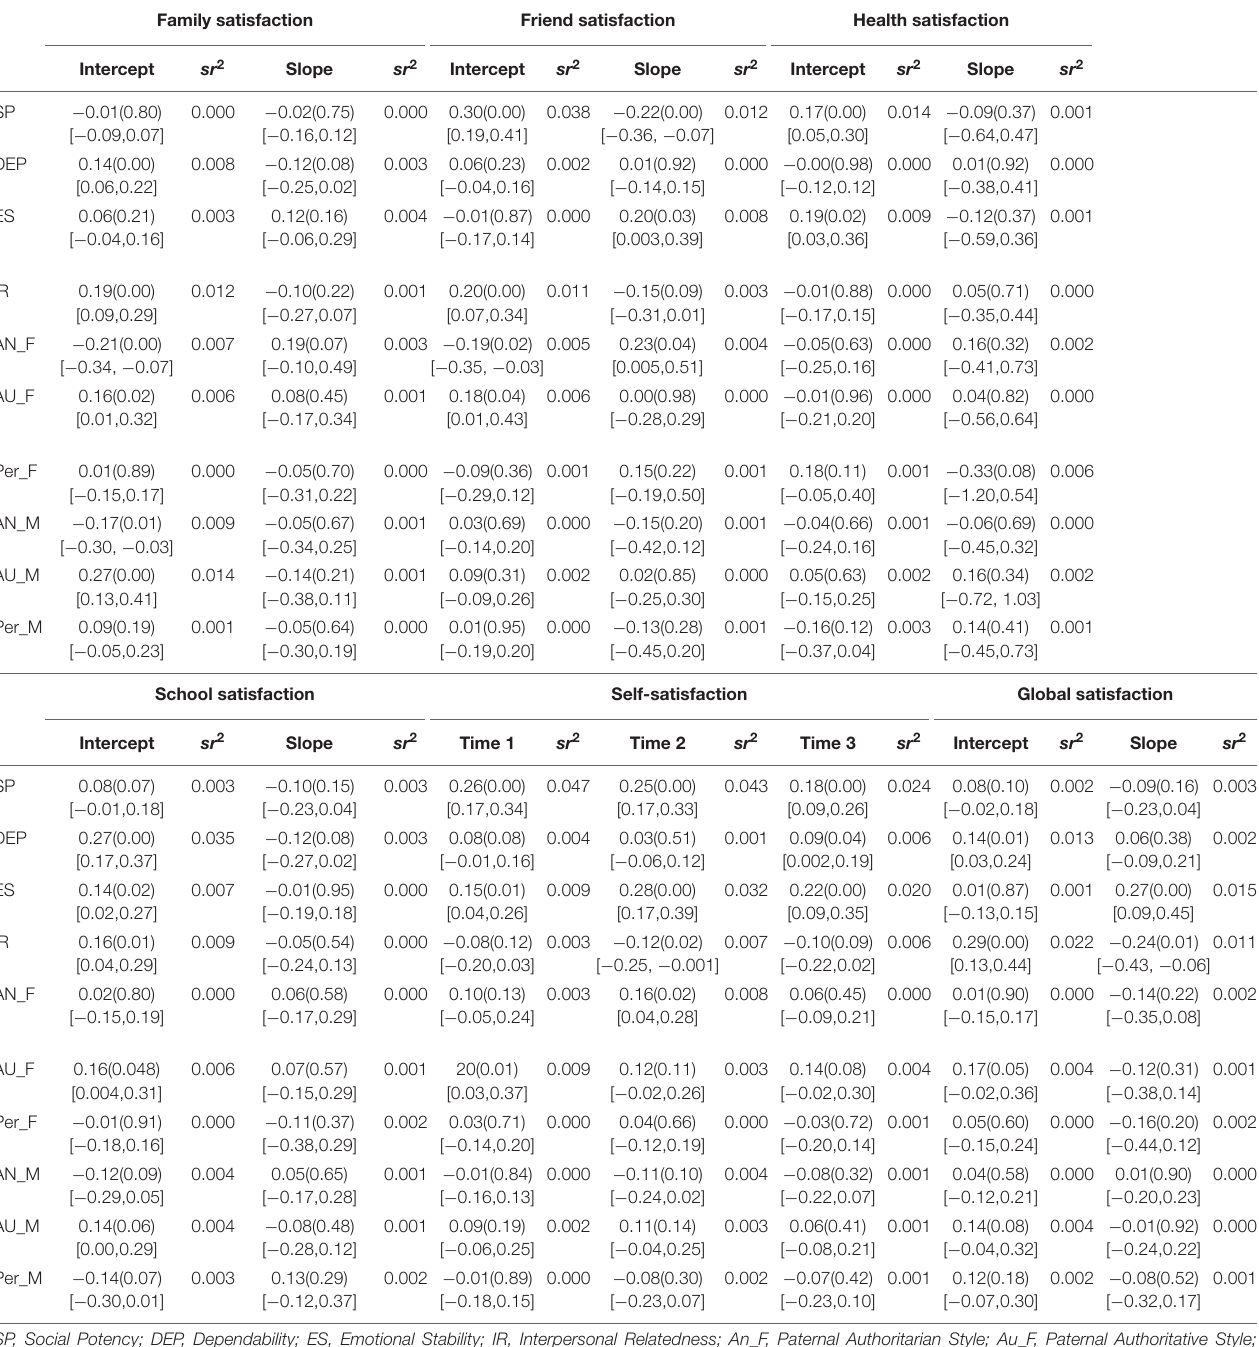
TABLE 4 | Regression analyses for predicting growth of life satisfaction by personality and parenting style. Family satisfaction Friend satisfaction Health